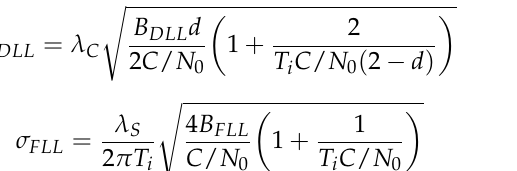
Table 7. Configuration settings used for the EKF covariance analysis. Parameter Value DLL Loop bandwidth ( B DLL ) 0.5 Hz Coherent integration time ( T i ) Early-late spacing ( d